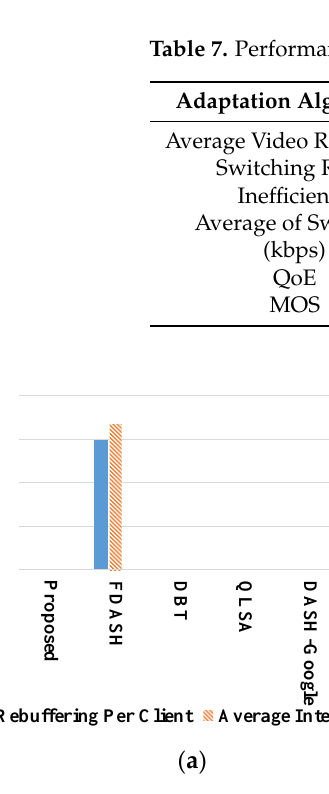
Figure 10. Comparison of ( a ) rebufferings per client, and average number of interruptions, and ( b ) average buffering time when the clients downloaded Dataset 2. The buffer size and segment duration were set to 15 s and 2 s, respectively.